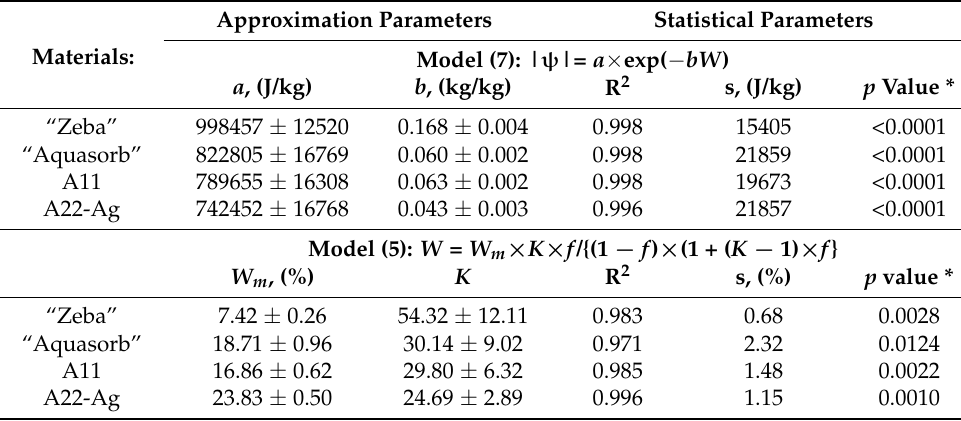
Table 1. Approximation indicators for fundamental models (7) and (5).